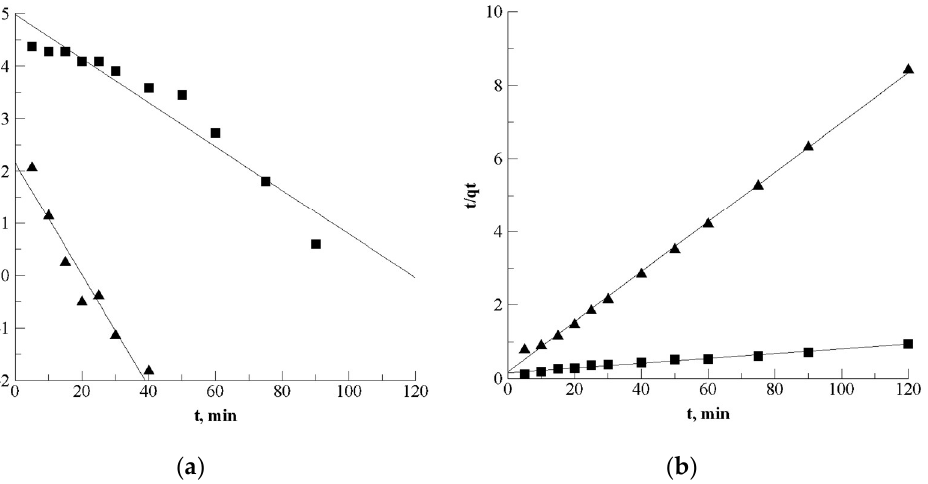
Figure 9. Modelling of ( (cid:4) ) sinigrin and ( (cid:78) ) gluconapin kinetics adsorption with PA312LOH resin (resin concentration 20 g/L, 30 ◦ C) using ( a ) pseudo first order model and ( b ) pseudo second order model. Table 4. Kinetic parameters for the adsorption of glucosinolates with PA312LOH resin. Kinetic Parameters Sinigrin Gluconapin